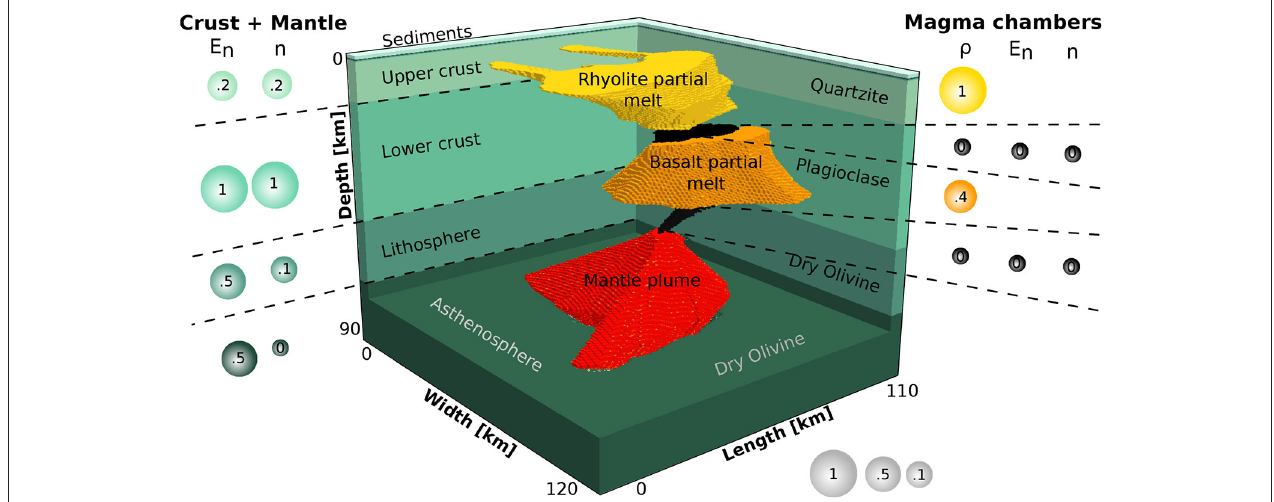
FIGURE 7 | Result of the adjoint parameter sensitivity study. The size of the sphere represents the relative importance of the parameter in affecting the surface velocity above the uppermost magma reservoir. Every physical parameter is normalized by its value for each rock phase (e.g., the activation energies of all phases are normalized with respect to each other). The viscosity of the lower crust, lithosphere and the lower crustal magma reservoir together with the densities of the magma reservoirs are the key model parameters.